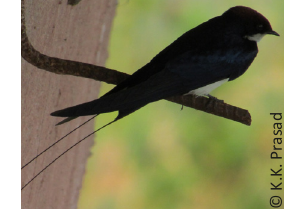
Image 51. Wire-tailed Swallow Hirundo smithii Image 52. Red-rumped Swallow